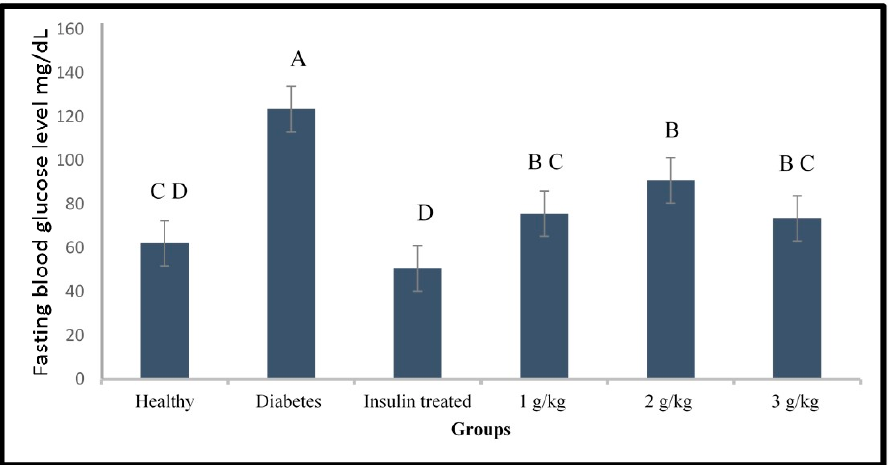
Figure 8. Fasting blood glucose level of diabetic zebrafish after treated with different doses of plant extract, comparing diabetes to healthy and insulin ‐ treated fish. Different capital letter indicates significant difference ( p < 0.05) among the values, n = 10.